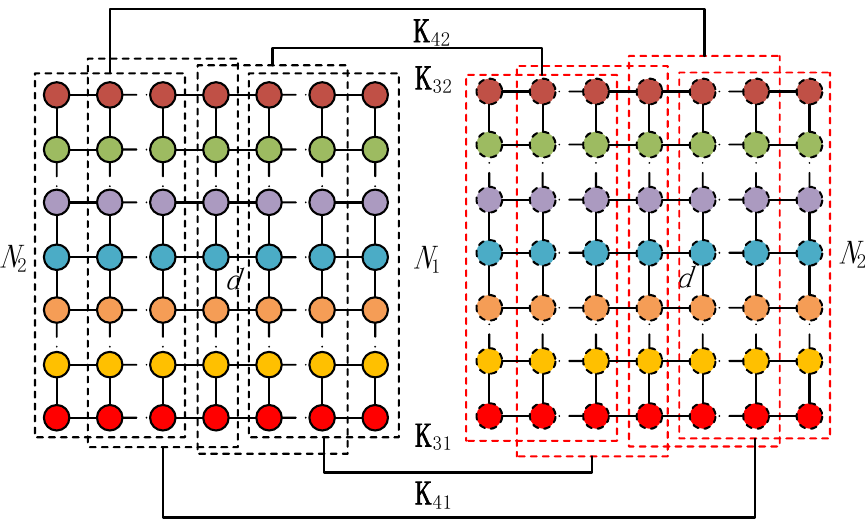
Figure 3. Block selection matrices for estimating ( θ k 3 , θ k 4 ) .